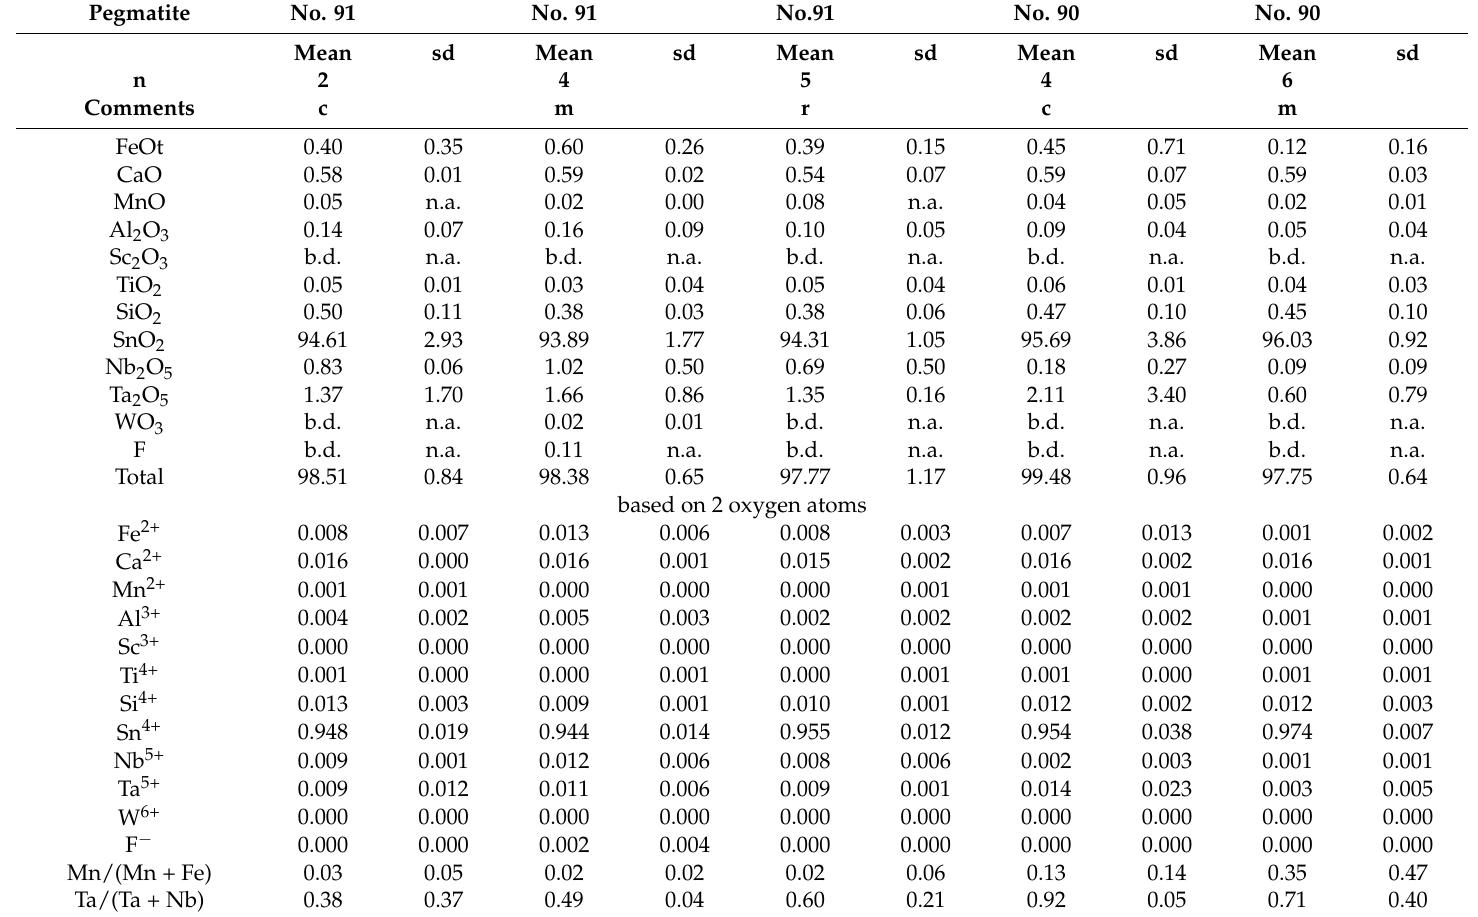
Table 2. Chemical composition (wt. % oxides and a.p.f.u.) of cassiterite in the Dahongliutan albite-spodumene pegmatites.